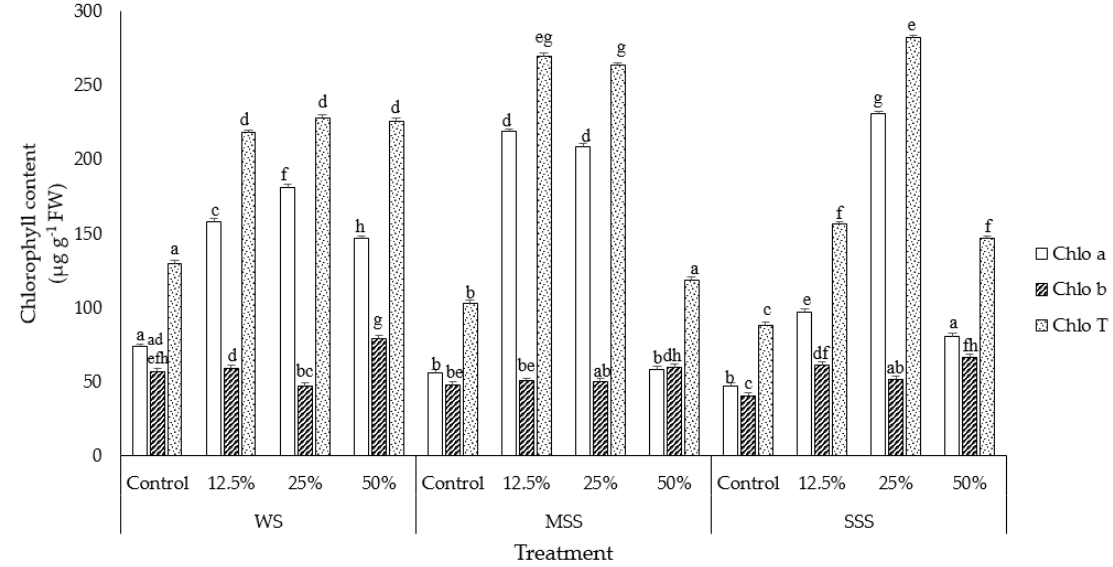
Figure 2. The effect of Salt stress on chlorophyll content in plant leaves of Triticum durum sprayed with SWE. Results are means ±SD. Different letters for each mean show statistically significant differences at p < 0.05. Abbreviations are as follows: WS: Without stress, MSS: Moderate salt stress, SSS: Severe salt stress, %: concentration of Ulva rigida extract in the solution of treatment, Chl a: Chlorophyll a, Chl b: Chlorophyll b, Chl T: Chlorophyll total, FW: Fresh weight.